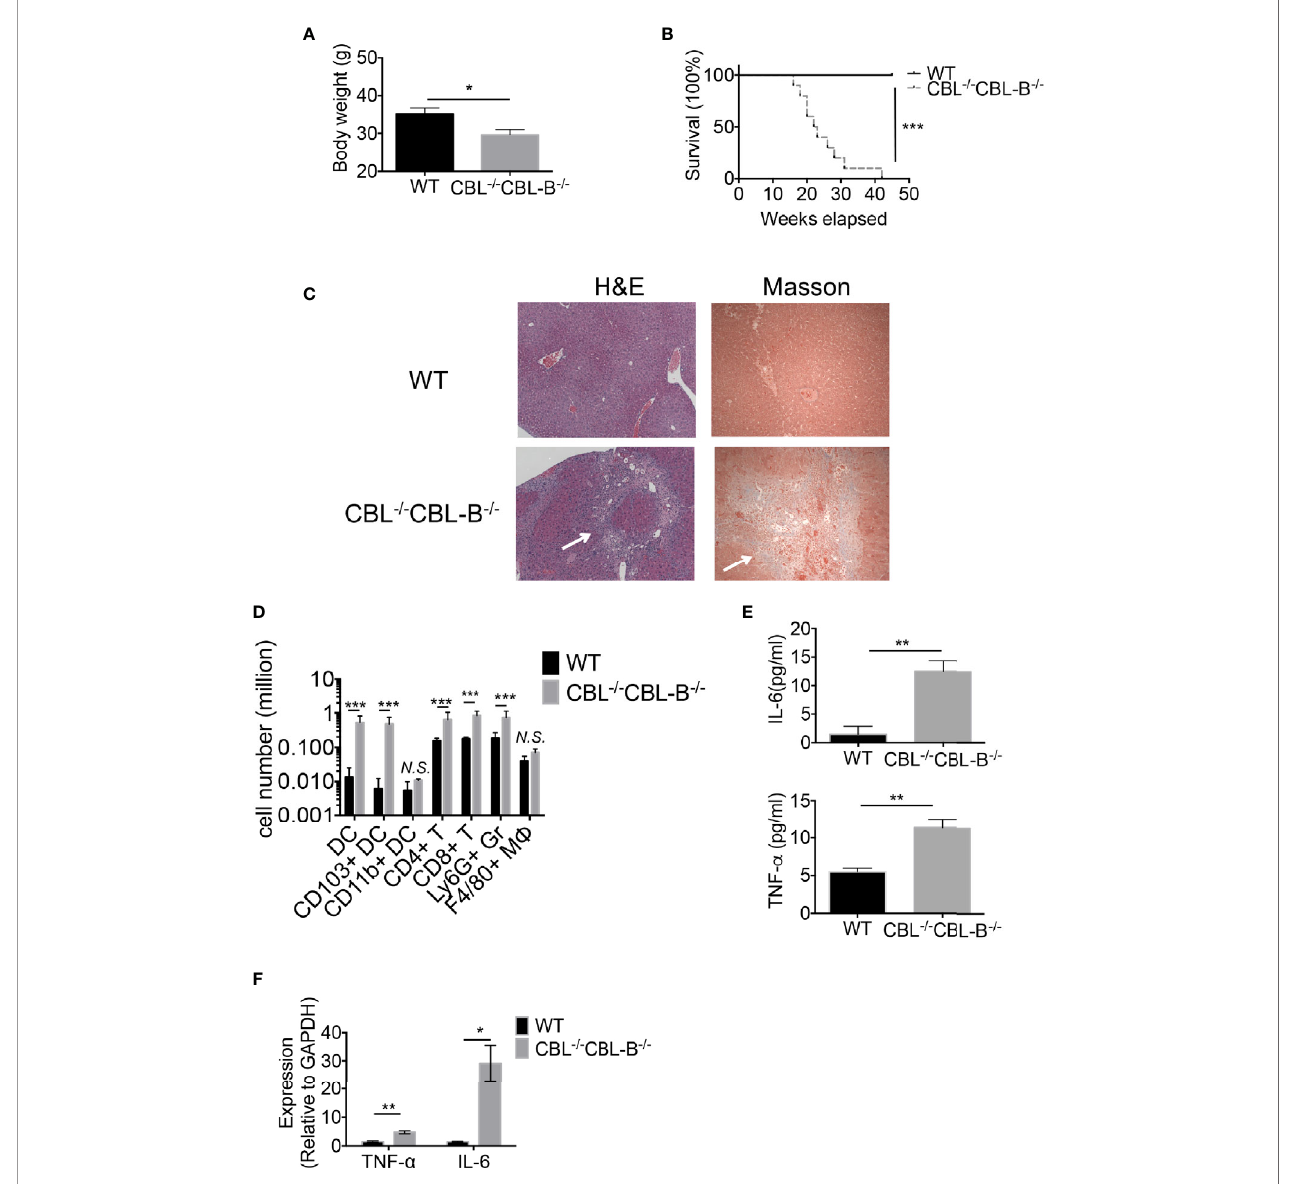
FIGURE 4 | CBL -/- CBL-B -/- mice have a reduced lifespan and severe in fl ammation. (A) Body weight comparison between 12-week-old WT and CBL -/- CBL-B -/- mice (n = 5). (B) Kaplan-Meier survival analysis of WT (n = 20) and CBL -/- CBL-B -/- (n = 20) mice. (C) Pathological analysis WT and CBL -/- CBL-B -/- mice. Shown are H-E staining and Masson staining of the liver. In fi ltrating leukocytes and liver fi brosis are indicated by arrows. (D) Flow cytometric analysis of liver leukocyte subsets. Shown are the statistics of in fi ltrated cell subsets of the gated CD45 + cells in livers from WT and CBL -/- CBL-B -/- mice (n = 5). DC: CD11c + MHC-II hi ; CD103 + DC: CD11c + MHC- II hi CD103 + CD8 a + ; CD11b + DC: CD11c + MHC-II hi CD11b + ; CD4 + T: TCR b + CD4 + ; CD8 + T: TCR b + CD8 + ; Ly6G + Gr: CD11b + Ly6G + ; F4/80 + M F : CD11b + F4/80 + . (E) Cytokine IL-6 and TNF- a secretion in serum (n = 5-6). (F) qPCR analysis of cytokine IL-6 and TNF- a expression in the liver (n = 3). Data are mean ± SEM. of at least two independent experiments (C – F) . N.S., not signi fi cant; *p < 0.05; **p < 0.01; ***p <